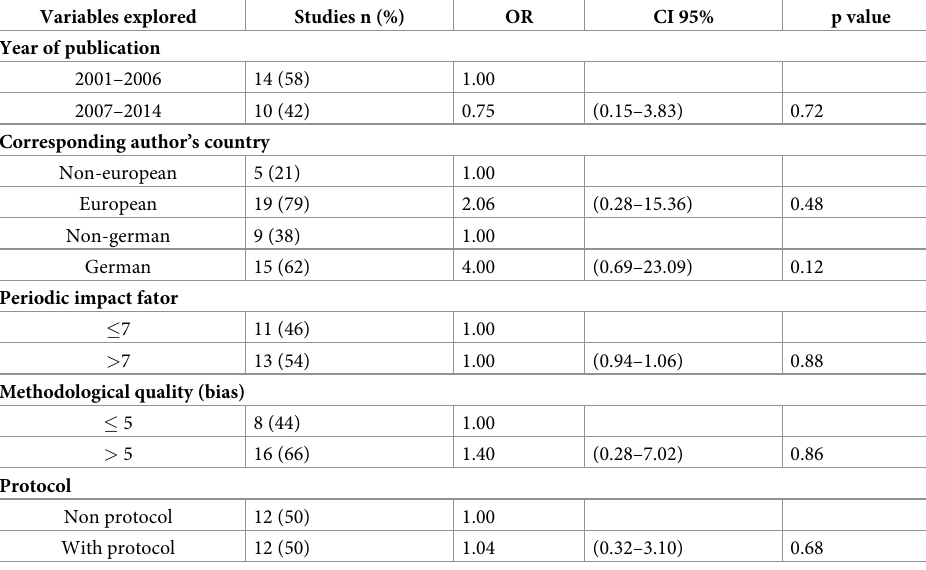
OR = odds ratio , CI = confidence